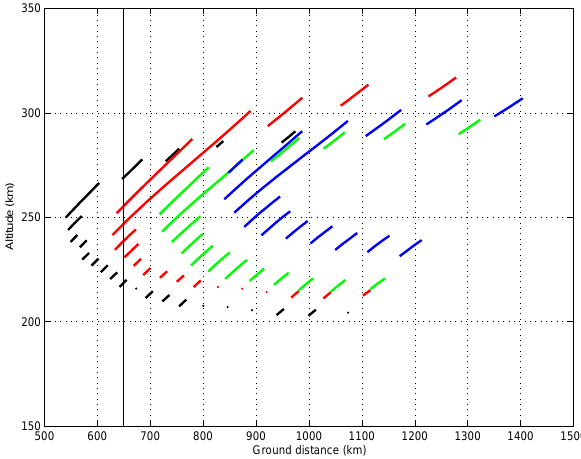
Fig. 3. The intervals of the ray paths within 1 ◦ of orthogonality to the magnetic field line direction over HAARP are shown for the Kodiak radar beam at 10MHz as a function of range and altitude. HAARP’s position is denoted by the vertical line. Black, red, green and blue correspond to 04:20, 04:55, 05:10 and 05:25 UT, respec- tively, on 25 February